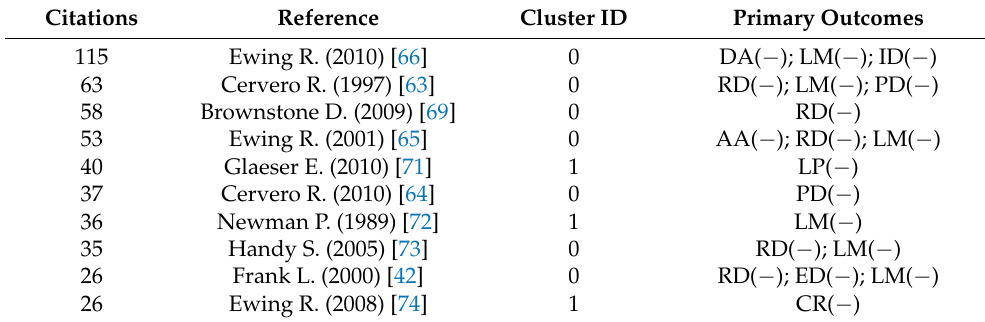
Table 3. Top-10 co-citation frequencies of the papers.